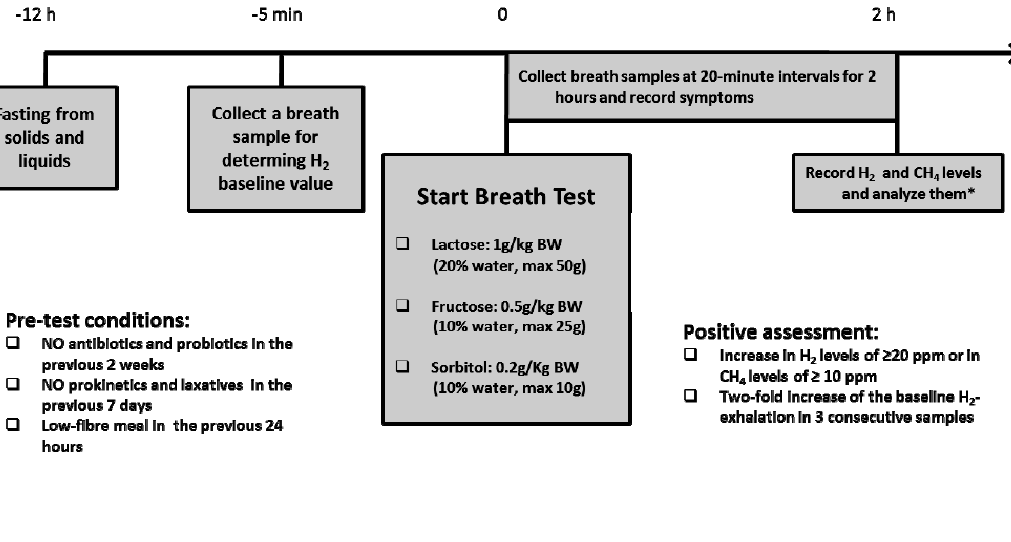
Figure 5. Breath test procedures in children with suspected carbohydrate intolerances.